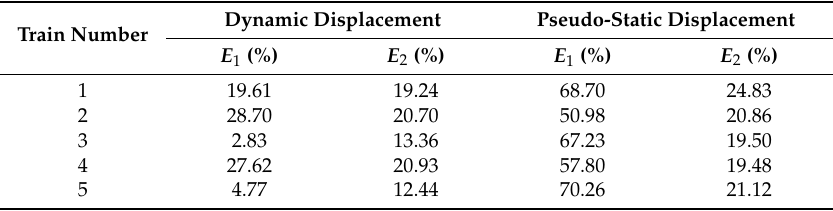
Figure 7. Reference and ( a ) Dynamic, ( b ) Pseudo-static, and ( c ) Total displacement: trains 1–5.